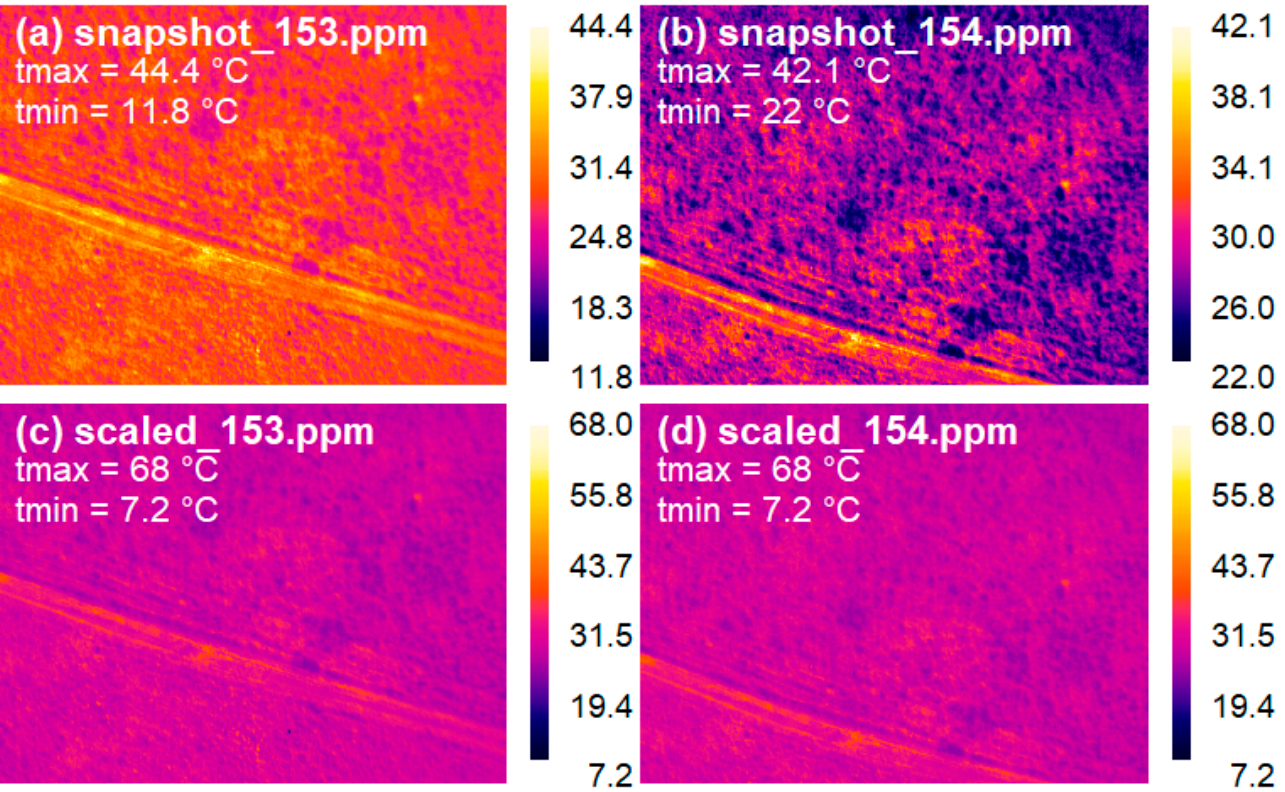
Figure 3. Illustration of the conversion process of thermal images. Raw thermal snapshots ( a , b ) are scaled to a common color (and temperature) range ( c , d ). The name of the file and the minimum and maximum temperatures of the images are shown in the upper left corner of the images.